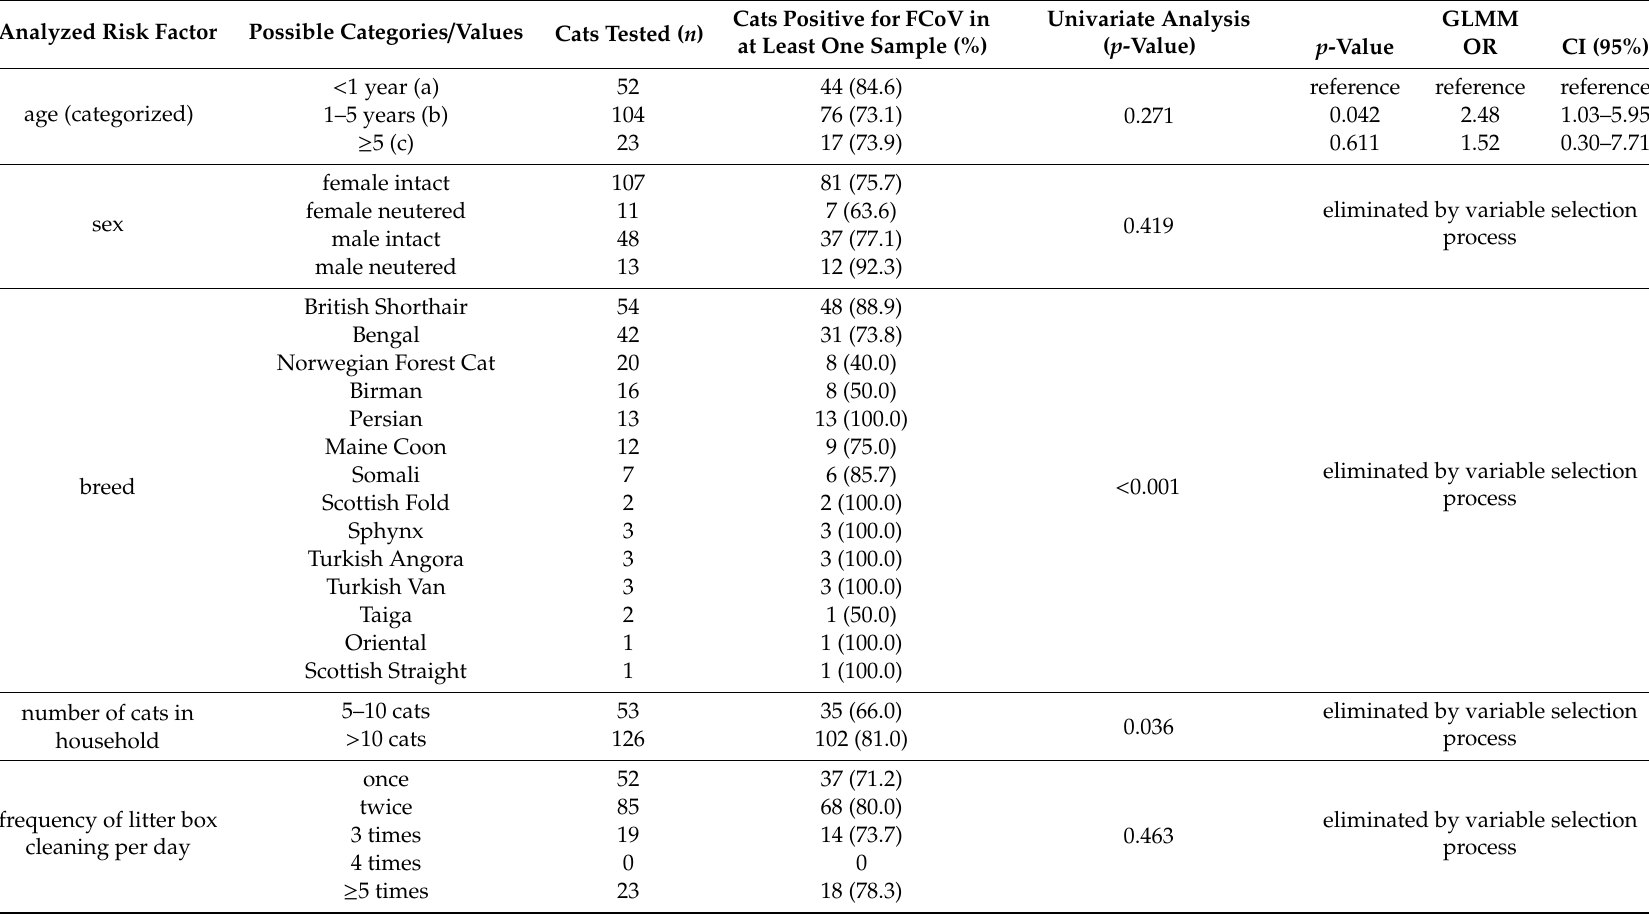
Table 4. Evaluated categorical risk factors and their influence on feline coronavirus (FCoV) shedding in univariate and multivariate analyses. Fisher’s exact test was used for univariate analysis. A generalized linear mixed model (GLMM) was used for multivariate